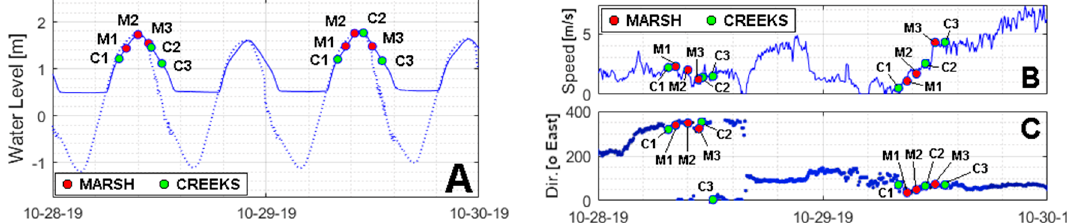
(dotted line) and the water level measured by an acoustic Doppler current profiler (ADCP) placed in the marsh (see Figure 4). Note that the flat water level region is at + 0.5 m, that is 0.69 m above the transducer level ( − 0.19 m). Due to a wrong setting we imposed on the minimum depth, the signature did not measure for depths < 0.69 m. ( B , C ) Wind speed and direction measured in the station “8670870 Fort Pulaski, GA”, in meters per second. Wind direction is the angle, in degrees from the north (clockwise), from which the wind originates. The dots represent the starting time of the unmanned aerial vehicle (UAV) survey. Red dots indicate the surveys performed on the marsh; green dots show the surveys conducted in the creeks and the main channel. For clarity, the subscripts “28” and “29” have been removed from the M1, M2, M3, C1, C2, C3 labels. Table 1. Day and starting time for the UAV flights performed on the Little Sapelo salt marsh (M1, M2, M3) and its creeks and main channel (C1, C2, C3) on the 28th and the 29th of October 2019. The day is added as subscript on the flight label. For instance, M1 28 refers to the first flight over the marsh on October 28th. Starting Hour Flight label